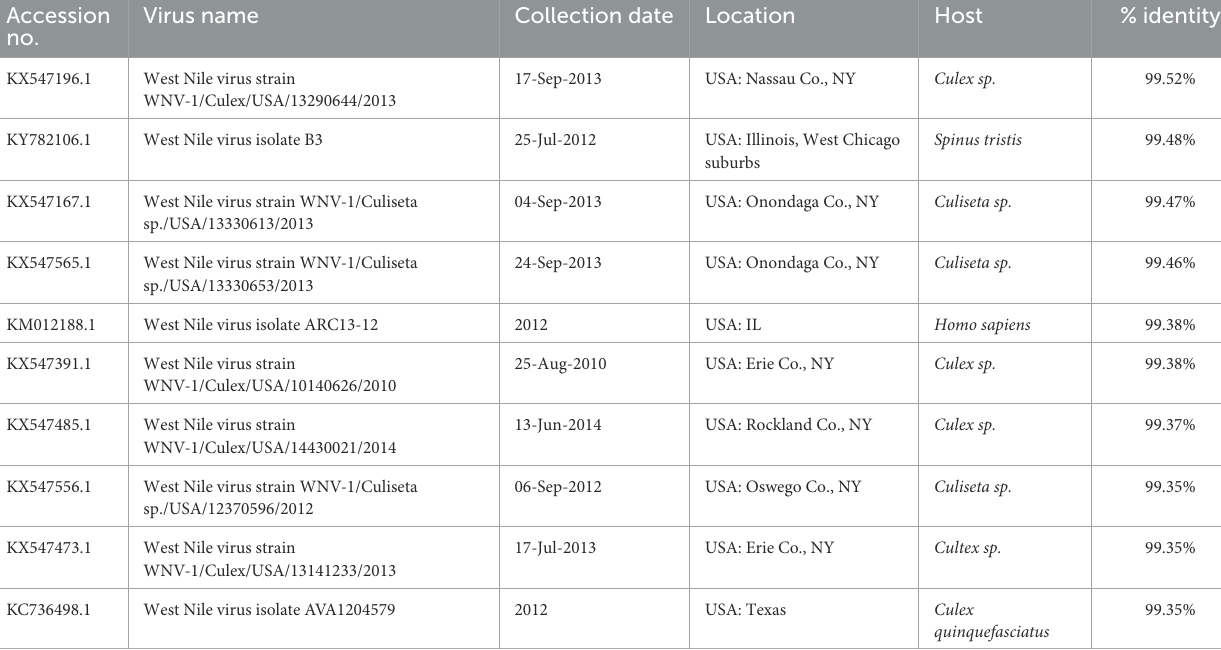
TABLE 1 Nucleotide sequence identities between the WNV 21-3782/USA MA/Alpaca/2021 virus and nearest virus homologs in the GenBank database (as of 15 May 2022). Accession